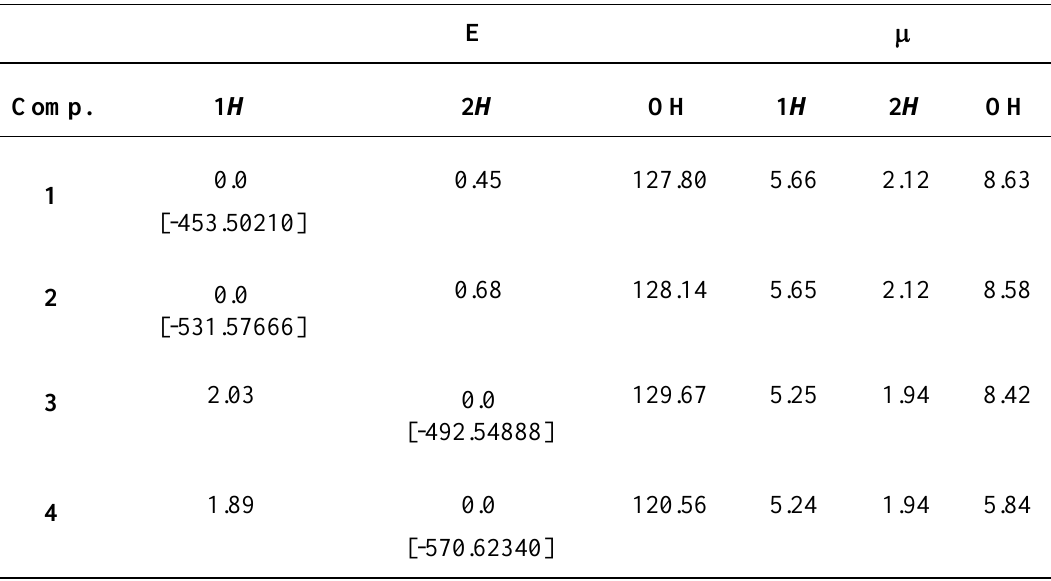
Table 3 . HF/ 6-31G** Differences in energy (kJ mol –1 ), energies in brackets (hartree) and dipole moments (Debye).